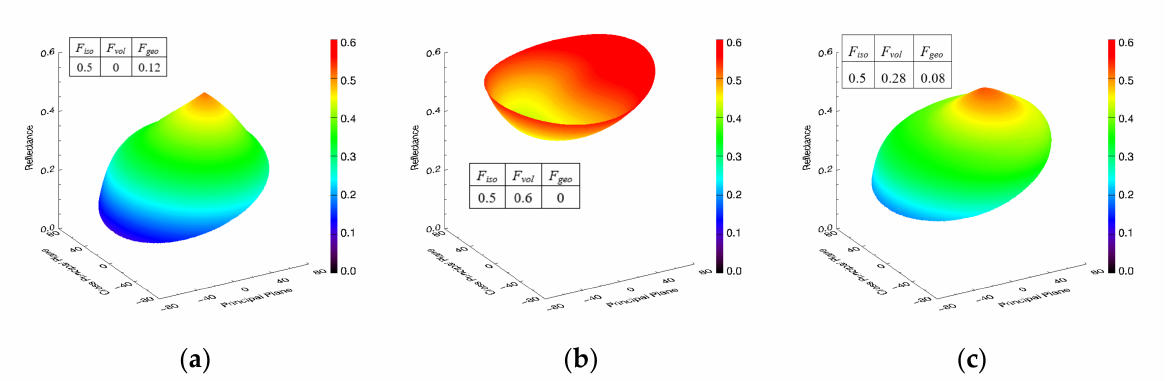
Figure 7. The model parameter and 3D shape of F g ( a ), F v ( b ), and F ( c ) with a solar zenith angle of 22 ◦ . For the bottom coordinate plane, the radius represents the zenith angle, and the polar angle represents the azimuth angle. The BRDF values are plotted on the vertical